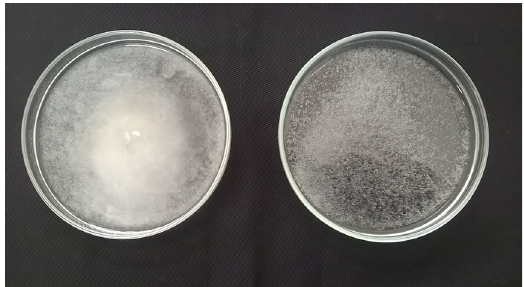
Figure 7. Samples (Left: with discharge, Right: control) after 15 minutes of cooling.